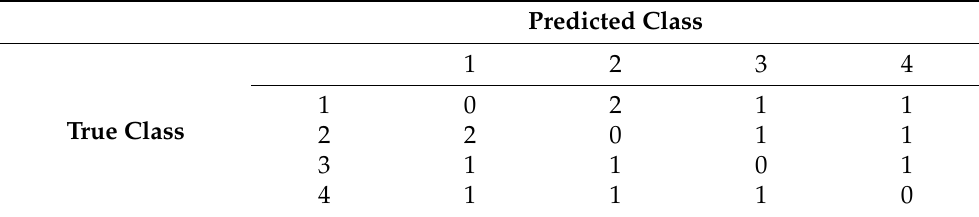
Table 2. Misclassification costs.